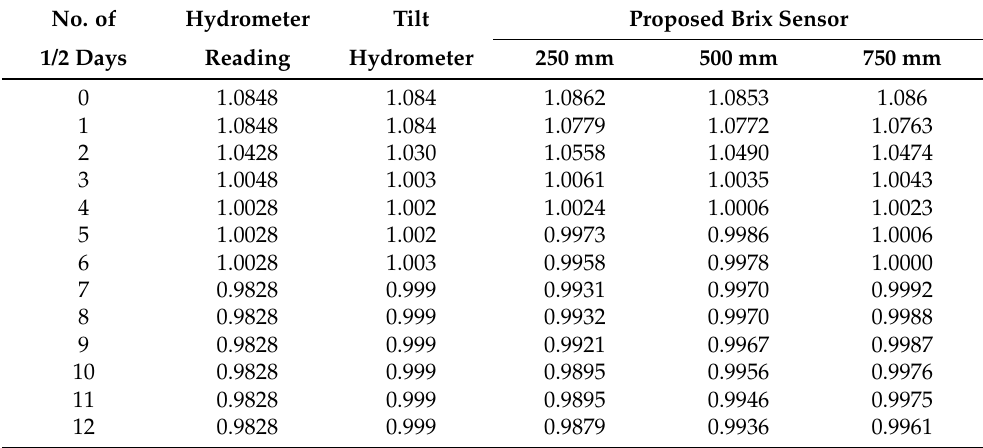
Table 6. SG values measured by a traditional hydrometer, Tilt hydrometer, and the proposed Brix